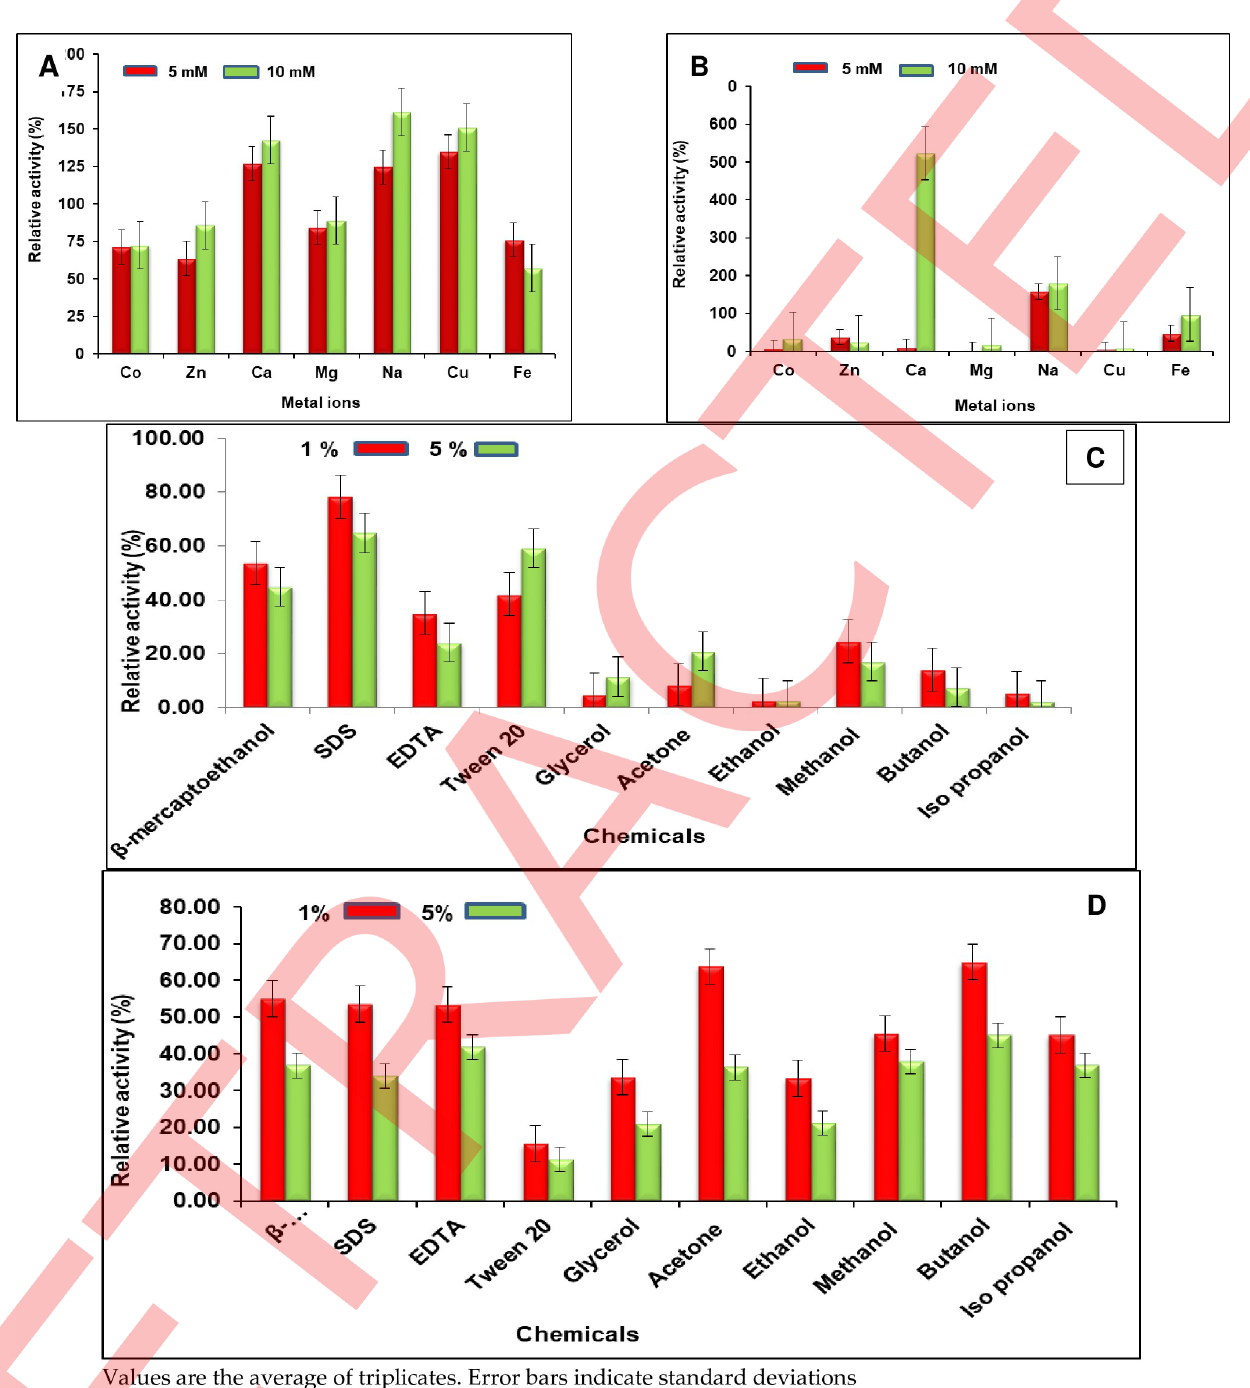
Fig 6. The effect of various metal ions (5–10 mM) on the activity of the protease and chitinase. Values are the average of five replicates and significant at P < 0.05 (A). The effect of various metal ions (5 mM and 10 mM) on the activity of chitinase. (B). Effect of denaturing agents and organic solvents at 1% and 5% on protease activity C). Effect of denaturing agents and organic solvents (1% and 5% of each) on chitinase activity (D).